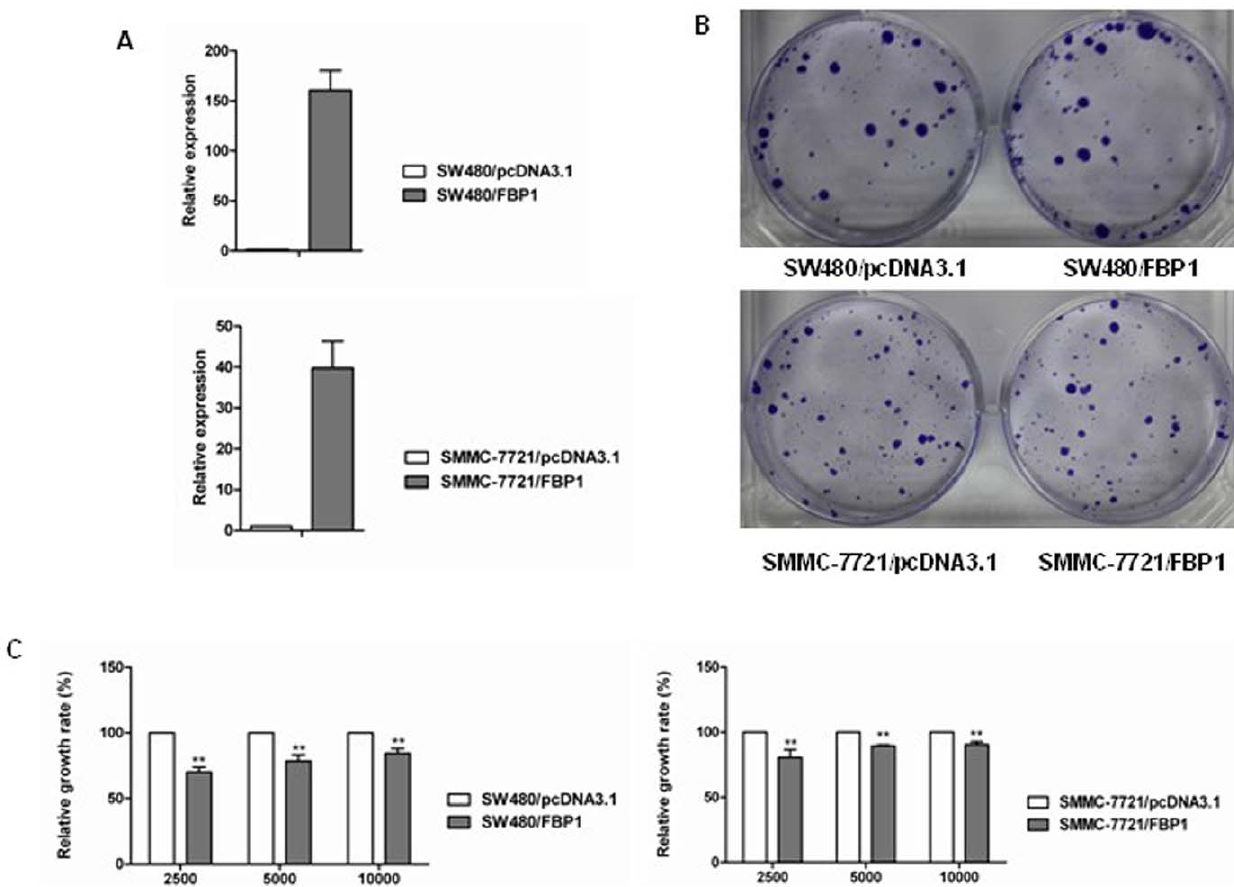
Figure 4. FBP1 overexpression reduced liver cancer cell colony formation abilities. ( A ) FBP1 expression level in the transfected SW480 and SMMC-7721 cells was confirmed by Real-Time RT-PCR. ( B ) The effect of ectopic FBP1 expression on liver cancer cell growth was investigated by the monolayer colony formation assay. The scanned colony formation in six-well plates was shown in the panel.. ( C ) The growth of liver and colon cancer cell lines (SW480 and SMMC-7721) with and without FBP1 expression was determined with MTS cell growth assay. Stable expression of FBP1 suppressed the growth of liver and colon cancer cells. The results were shown as values of mean 6 SD. P values were calculated using Student’s t-test (* p ,